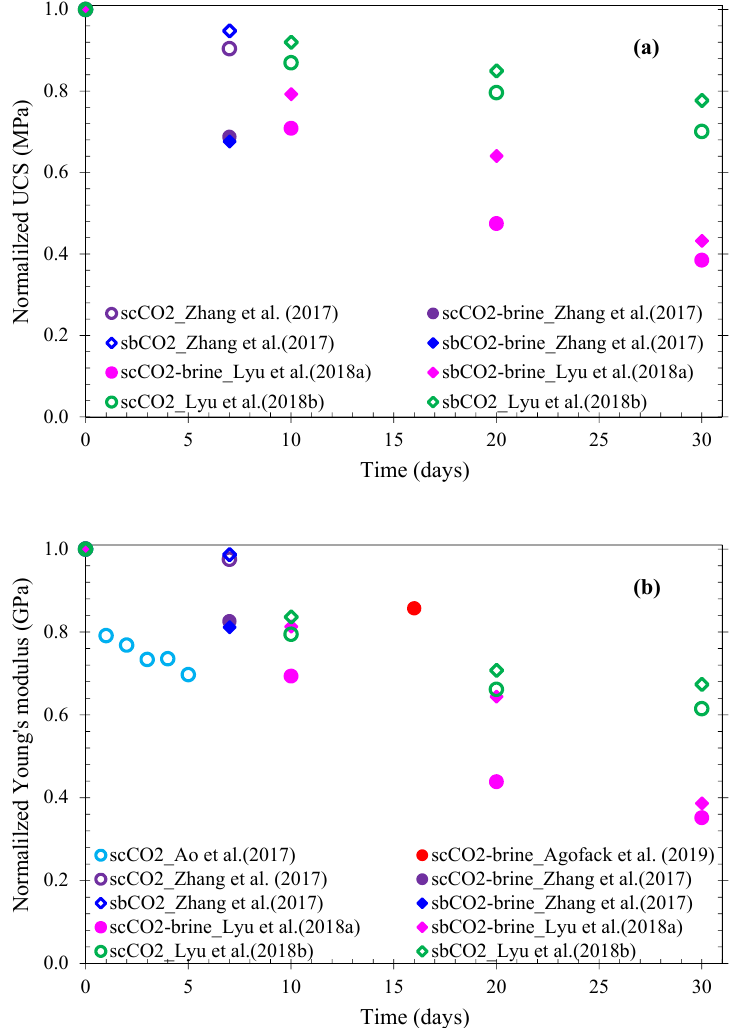
Figure 5. Variation of the normalized UCS ( a ) and Young’s modulus ( b ) with exposure time in CO 2 and CO 2 –brine. The normalization is done by dividing the value at a given time by the initial value (without CO 2 ). The nomenclature consists of the exposure fluid followed by the references [e.g., scCO 2 –brine_Zhang et al. [168] refers to the shale sample exposed to supercritical CO 2 –brine investigated by Zhang et al.].